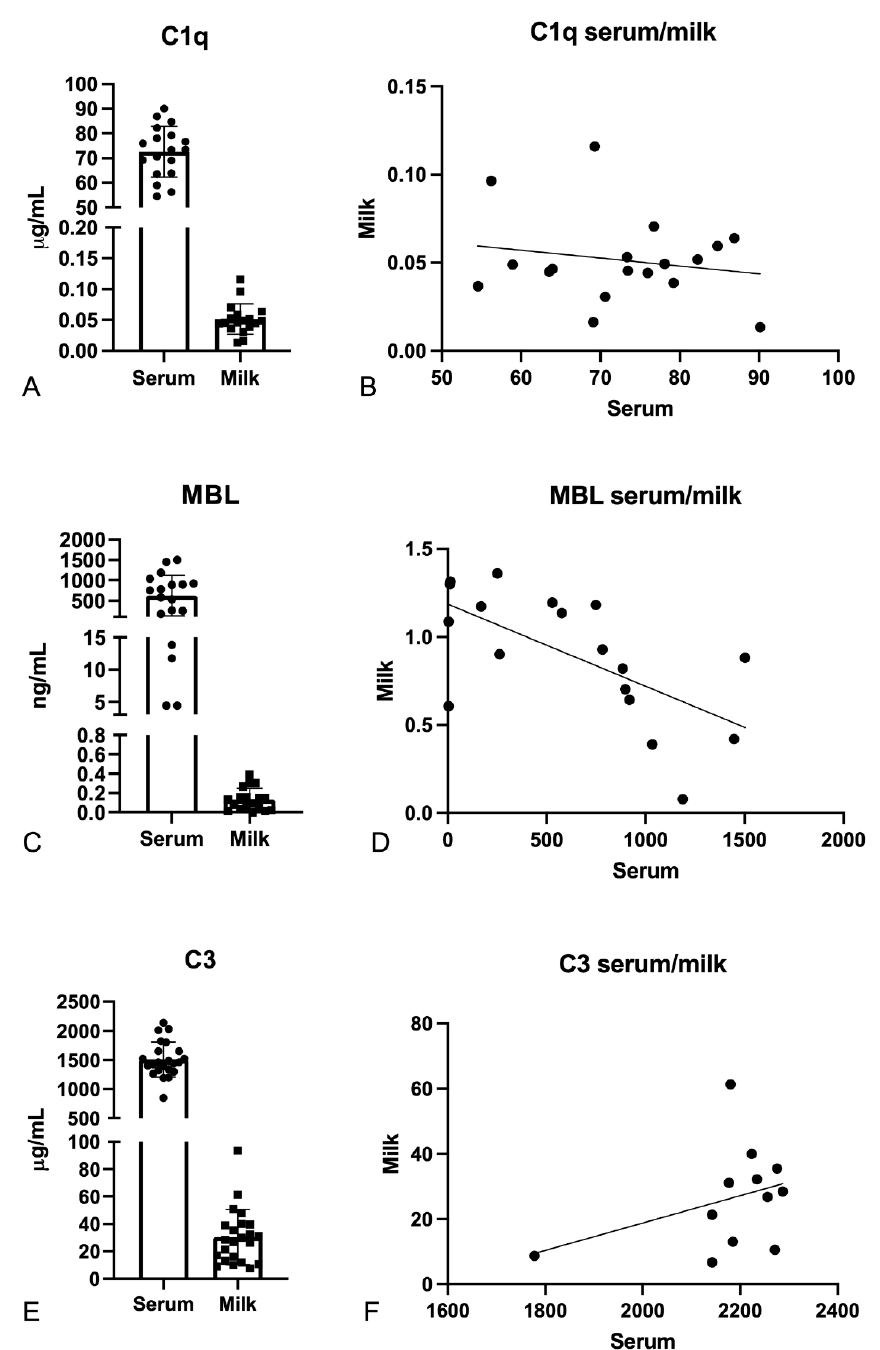
Figure 2. C1q, MBL, and C3 levels in serum and milk of vaccinated women. The levels of the three complement pathway activators (C1q, MBL, and C3) were evaluated using commercial ELISA kits. C1q and MBL levels appeared to be higher in serum than in milk samples ( A , C ); however, no correlation was found between the two biological fluids ( B , D ). C3 measurement revealed an abundance of this complement activator in milk, although the level remained lower than in serum ( E ). No correlation was found between C3 serum and milk concentrations ( F ).